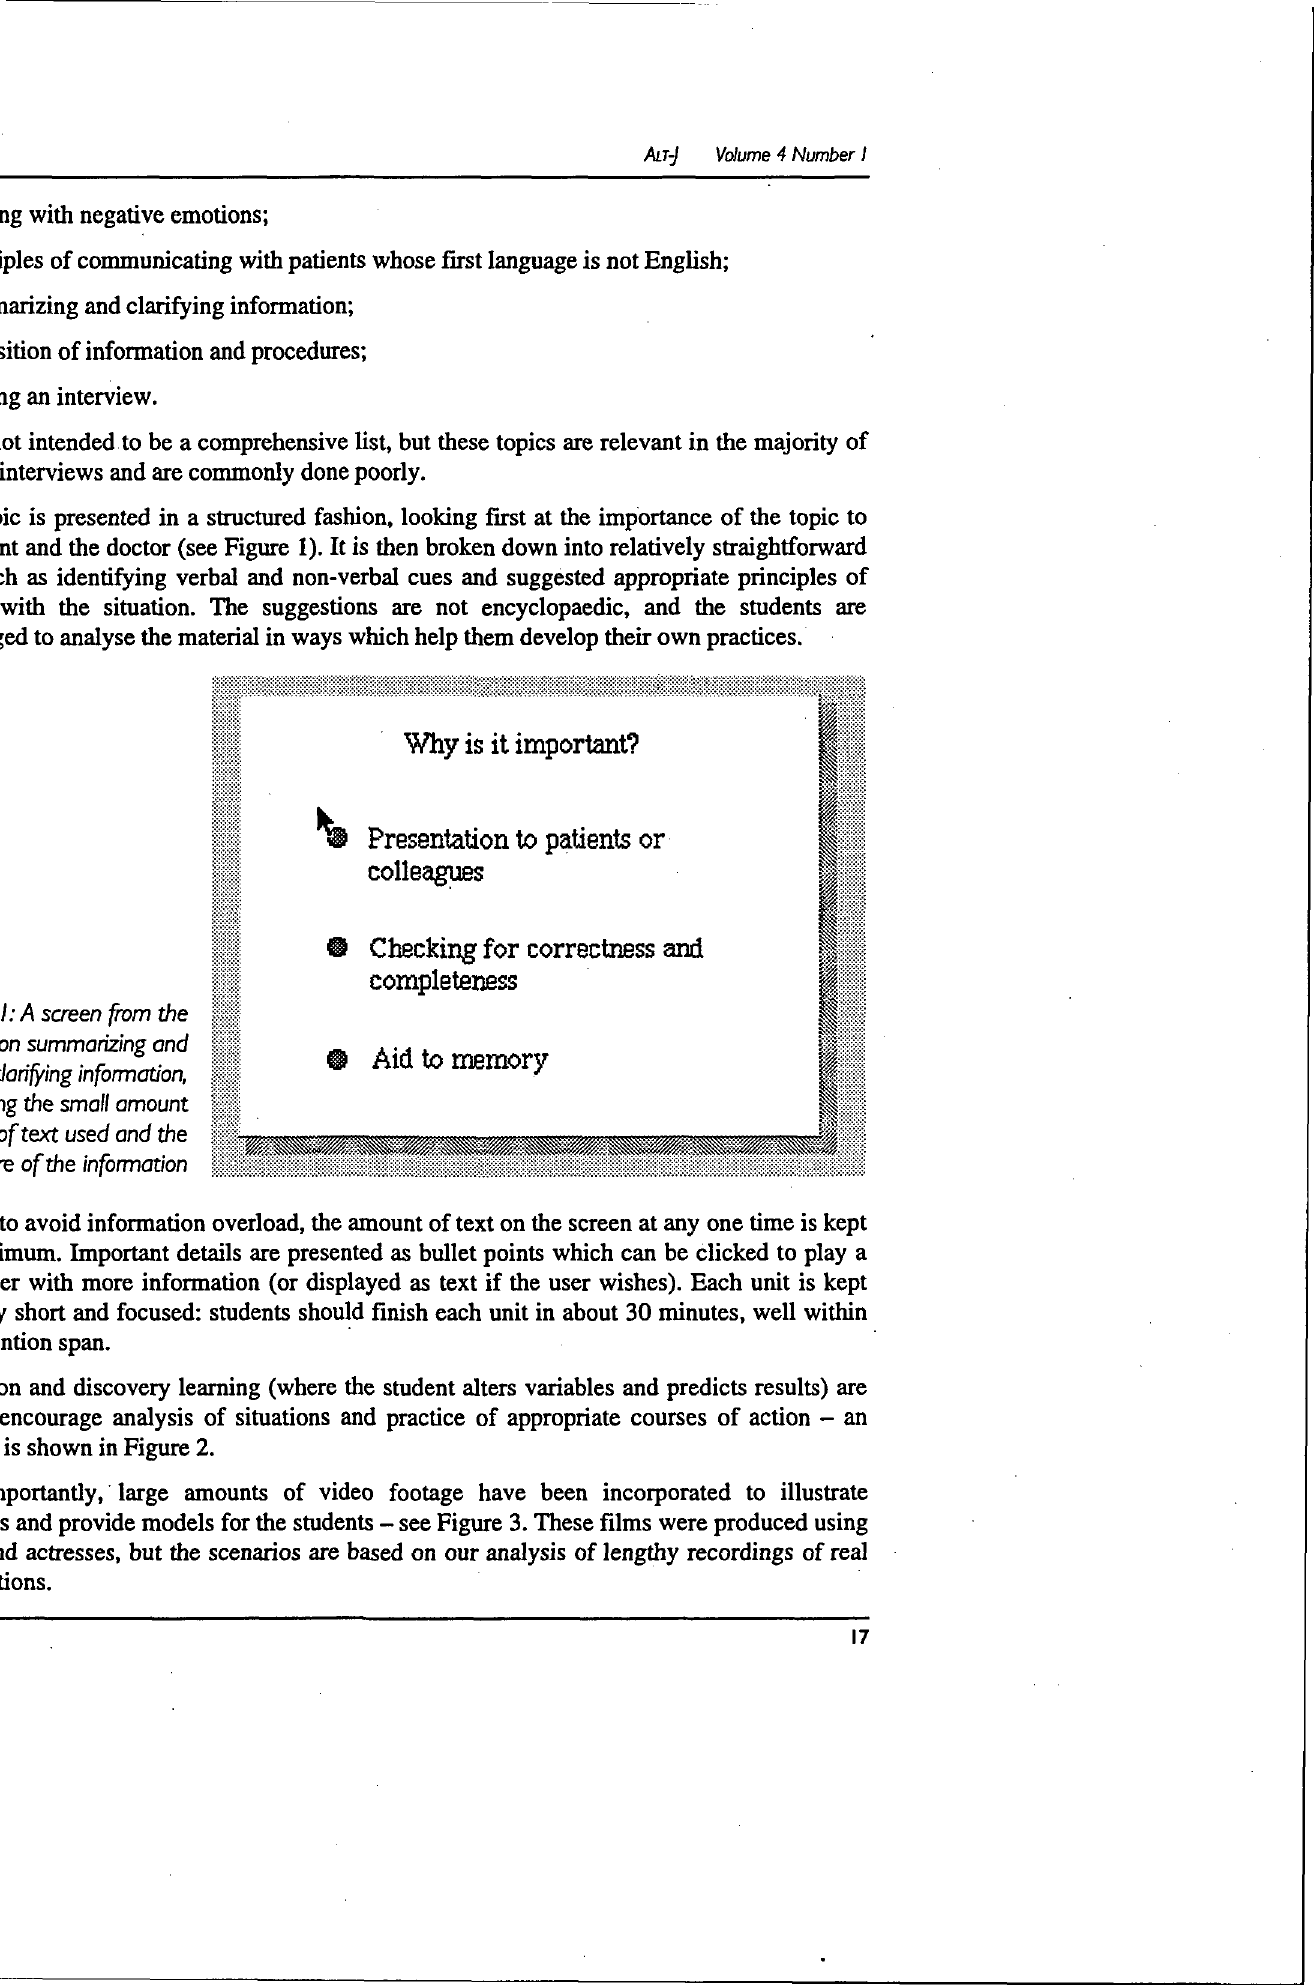
Figure /: A screen from the unit on summarizing and _ clarifying information, illustrating the small amount of text used and the structure of the